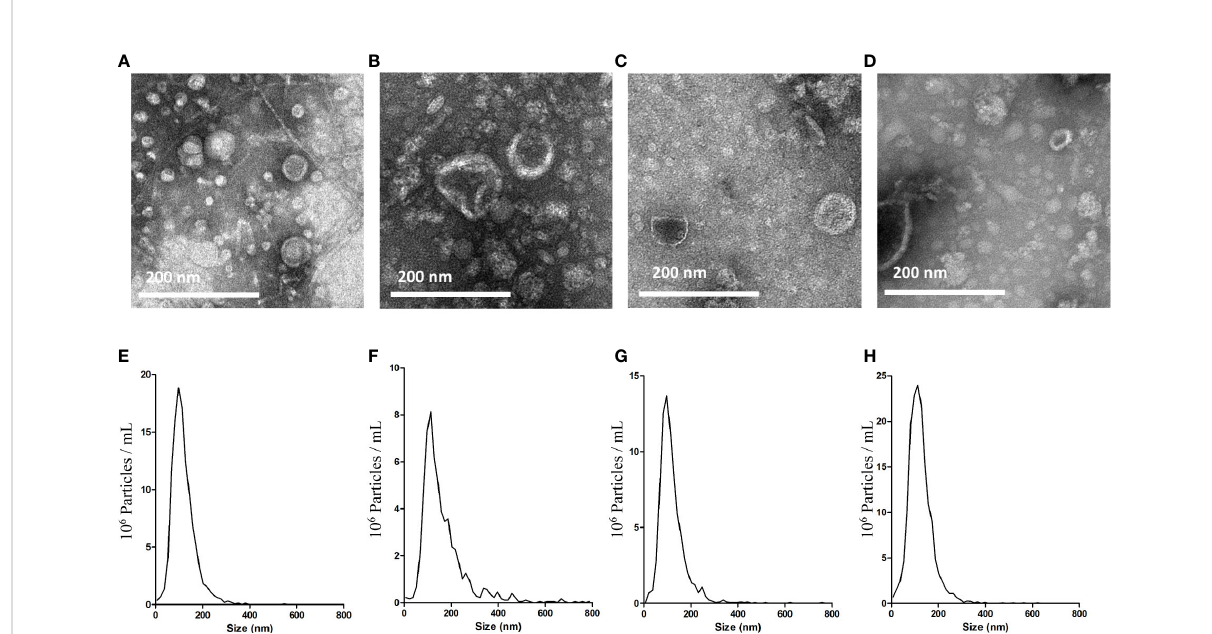
FIGURE 2 Characterization of BEVs using TEM and NTA. TEM images of BEVs derived from E. coli isolated by UC (A) or PL (B) . TEM images of BEVs derived from S. aureus isolated by UC (C) or PL (D) . Representative particle size-distribution curve of BEVs derived from E. coli isolated by UC (E) or PL (F) . Representative particle size-distribution curve of BEVs derived from S. aureus isolated by UC (G) or PL (H) .